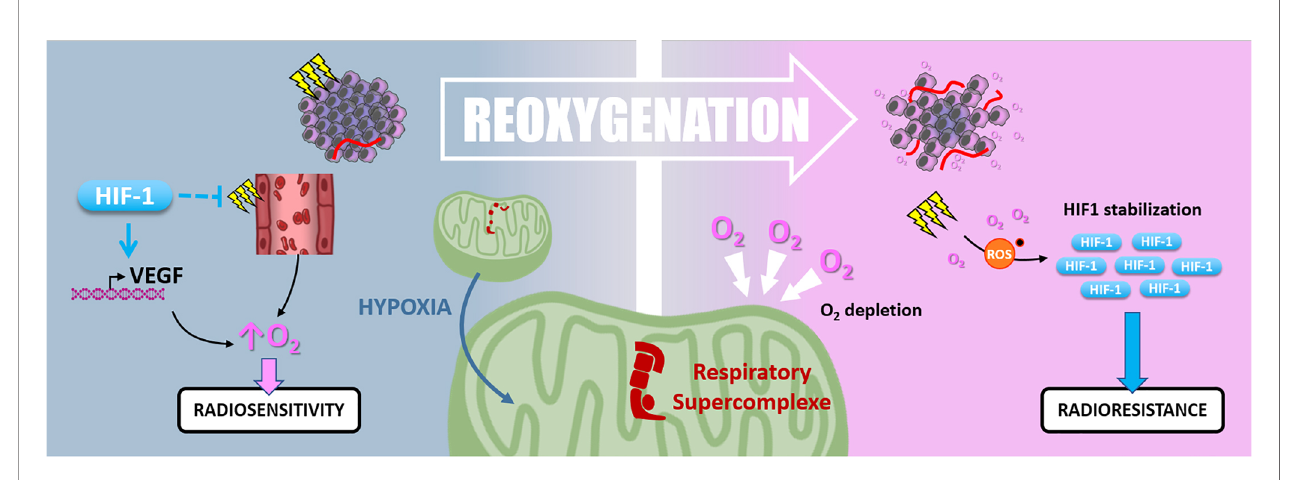
FIGURE 7 | Reoxygenation. Radiotherapy induces tissue reoxygenation through O 2 release and angiogenesis. Hypoxia also favors reoxygenation since HIF1 protects endothelial cells from irradiation and promotes VEGF expression. Nevertheless, hypoxia induces mitochondrial respiratory supercomplexes formation, which could persist after reoxygenation and cause high O 2 consumption and depletion. Oxidative stress due to irradiation and reoxygenation stabilizes HIF-1, which can maintain